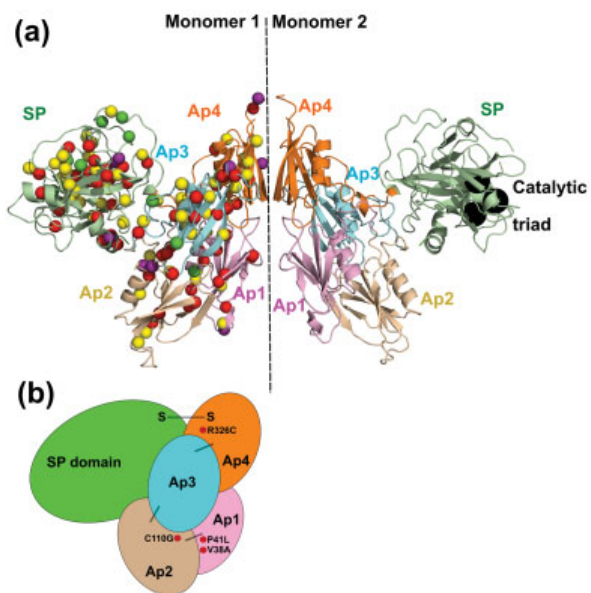
Fig. 5 Structural and schematic view of variants within FXI. The dimer was created using its crystallographic symmetry, with the two Ap4 domains in contact with each other about an axis depicted as a dashed vertical line. (a) Distribution of 142 missense variants and 14 poly- morphisms within dimeric FXI. The crystal structure of the FXI dimer is shown in ribbon format, with the C α positions of variants and poly- morphisms highlighted as spheres. Variant locations are illustrated in Monomer 1 and are colored according to phenotype. Type I (CRM-) variants are in red, Type II (CRM þ ) variants in green, and those with unknown phenotype in yellow. The non-disease associated polymor- phisms are depicted in purple. The catalytic triad His431-Asp480- Ser575 (legacy numbering His413-Asp462-Ser557) is shown in the SP domain of Monomer 2 as black spheres. The ribbon colors correspond to those used on our Web site https://www.factorxi.org. (b) Sche- matic representation of the fi ve domains in monomeric FXI. The fi ve domains are aligned and depicted in the same orientation and colors as in the ribbons in (a) above. The highlighted four variants, Val38Ala, Pro41Leu, Cys110Gly and Arg326Cys, are Type I variants found at interdomain contact points (see